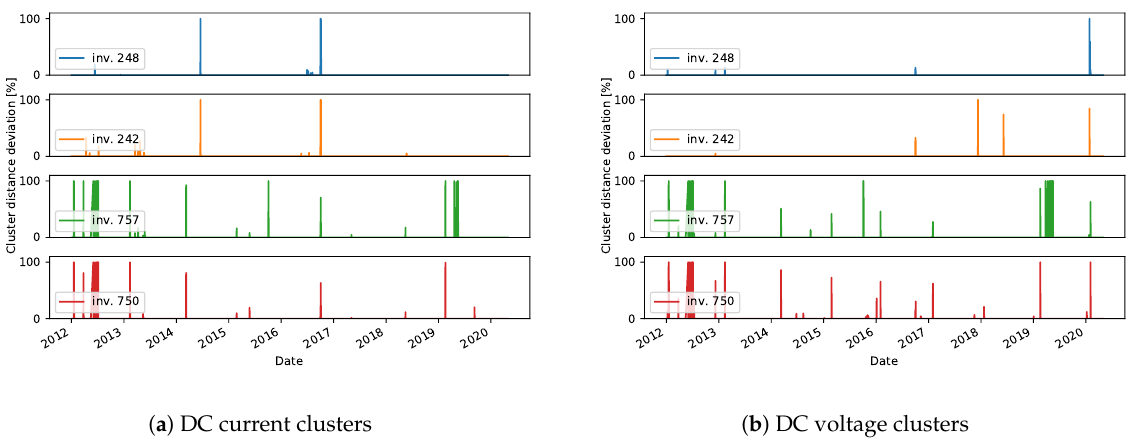
Figure 14. Unusual day event detection in plant